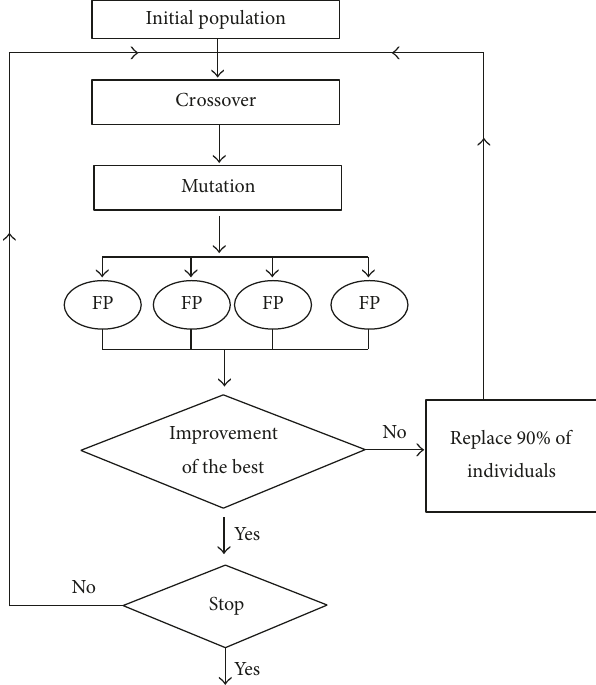
Figure 17: Hybrid algorithm.